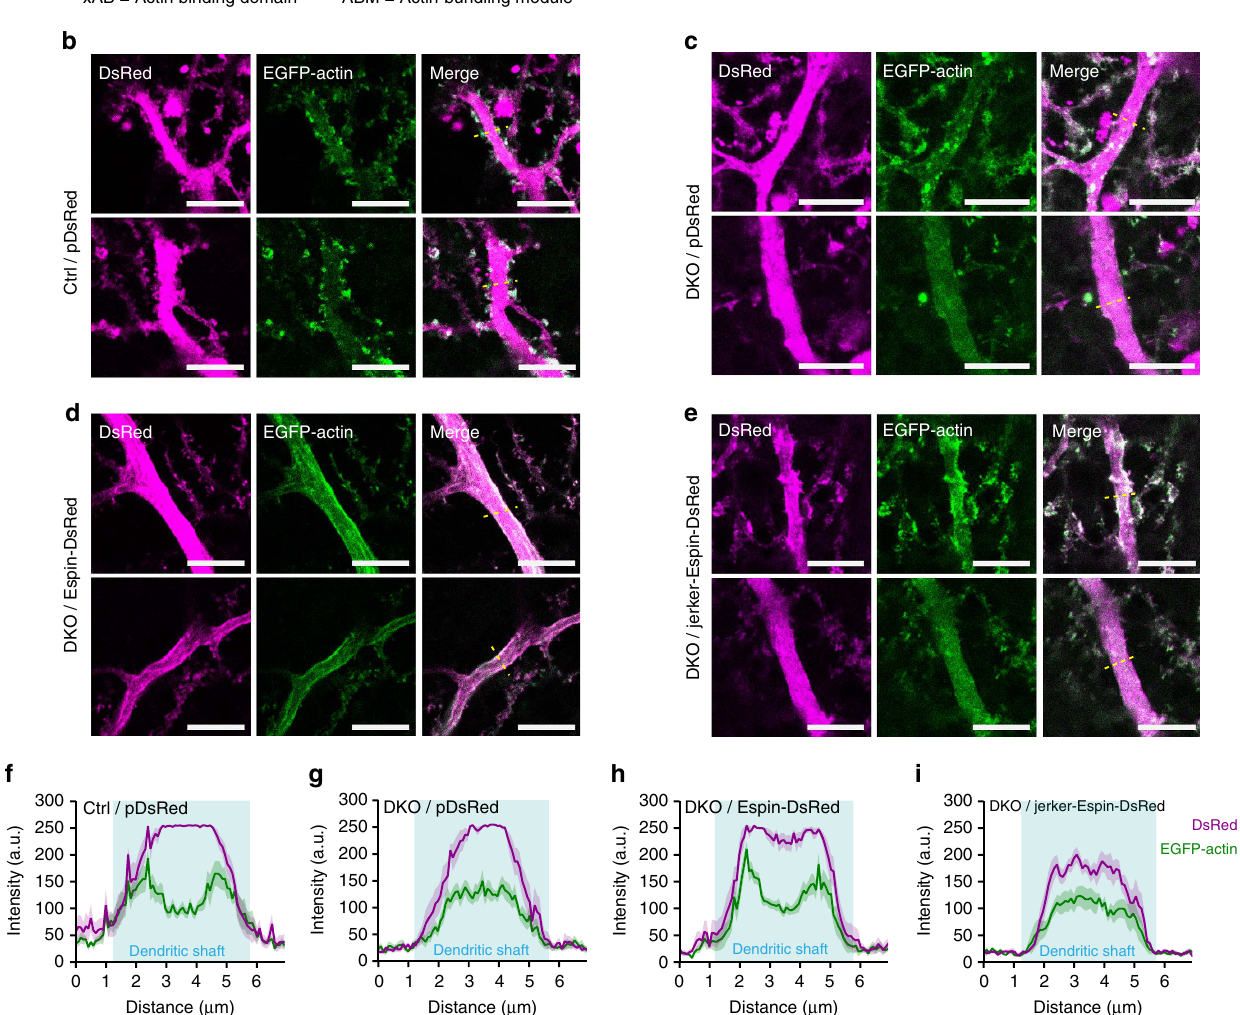
Figure 7 | C-terminus of actin-bundling module of Espin is required for proper F-actin localization. ( a ) Schematic representation of Espin-DsRed and jerker-Espin-DsRed. The nucleotide in blue (marked by asterisk) was deleted and resulted in a frameshift mutation in C-terminus of jerker-Espin. The resulting jerker-Espin-DsRed had a shorter and mutated actin-bundling module ( ABM* ). ( b – e ) Central focal planes of the PC proximal dendrites from P14 control ( b ) or DKO mutant ( c – e ) co-transfected with EGFP-Actin and pDsRed ( b , c ) or Espin-DsRed ( d ) or jerker-Espin-DsRed ( e ). Scale bars, 10 m m. ( f – i ) Fluorescence intensity profile plots (across the yellow doted lines) reveal the distribution of F-actin in the dendritic shafts of the proximal dendrites of the transfected PCs, respectively. Areas shaded in cyan represent the dendritic shafts. Each profile plot was sampled from 10 different PCs from 4 to 5 different mice and the curves represent mean ± s.e.m. Note that the F-actin localization in the mutant PCs restored to the controls’ pattern after transfection of